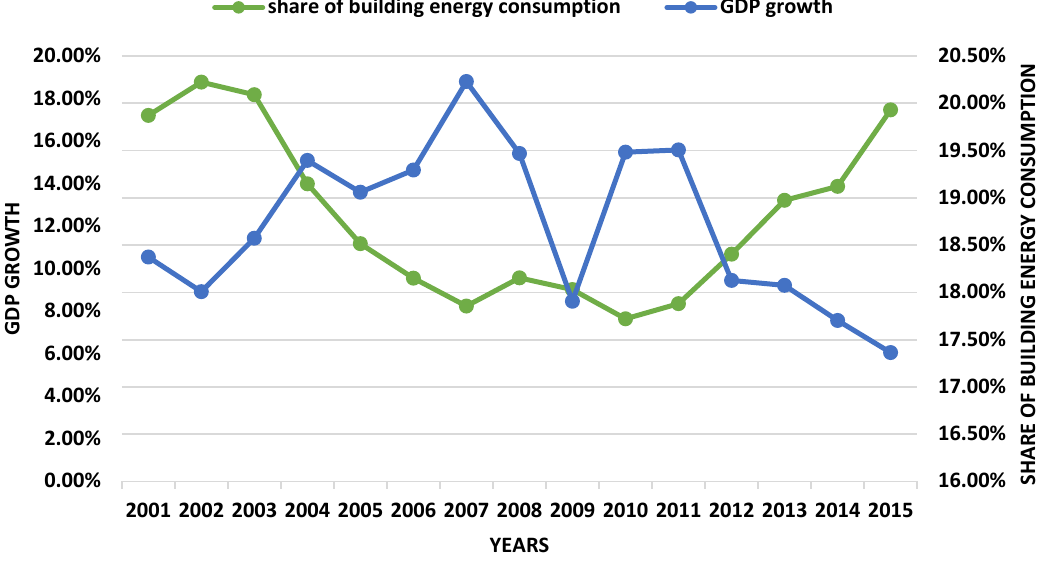
Figure 6. Share of Building Energy Consumption vs. GDP Growth. Data source: GDP data is from [19].